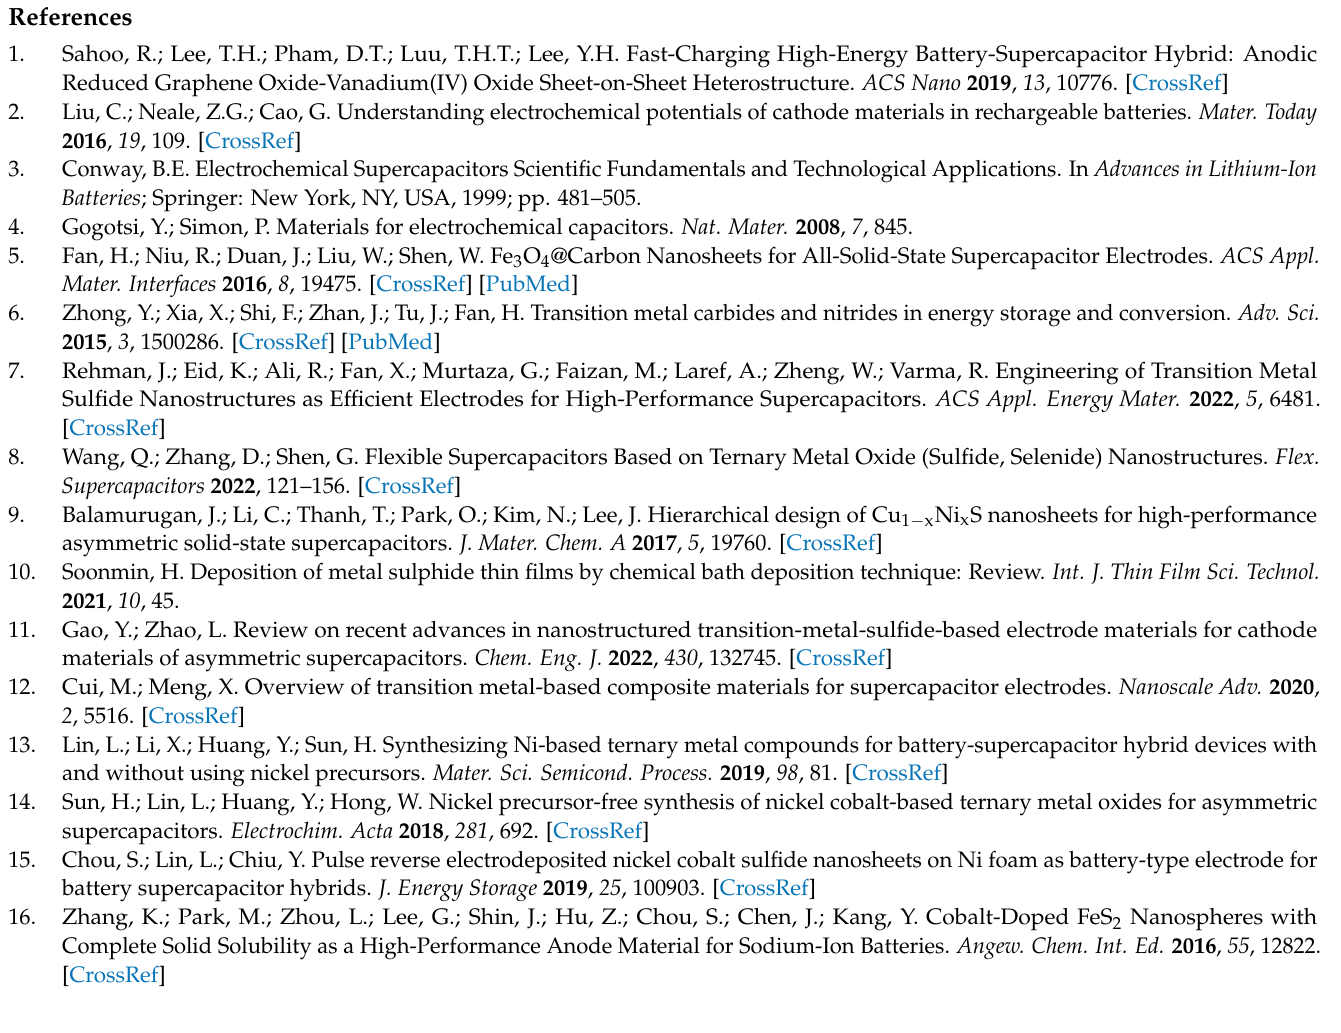
Schematic representation of coin cell assembly with their parts; Table S1: Data table for quantitative elemental distribution (wt. %) of MFS